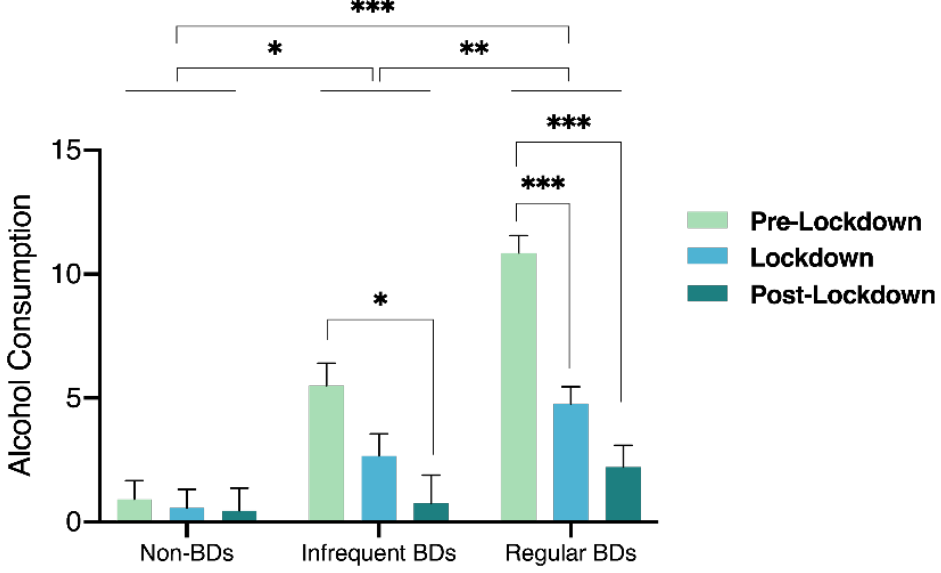
Figure 1. Bar chart depicting the results of the linear mixed-effects model (LMM) testing the associations between the moment of assessment (Pre-Lockdown, Lockdown, and Post-Lockdown) and Group (Non-BDs, Infrequent BDs, and Regular BDs) with alcohol consumption (i.e., drinks per week) and an interaction term (Moment × Group). Asterisks denote significant pairwise comparisons; * p < 0.05, ** p < 0.005, and *** p < 0.001. BD = binge drinkers.